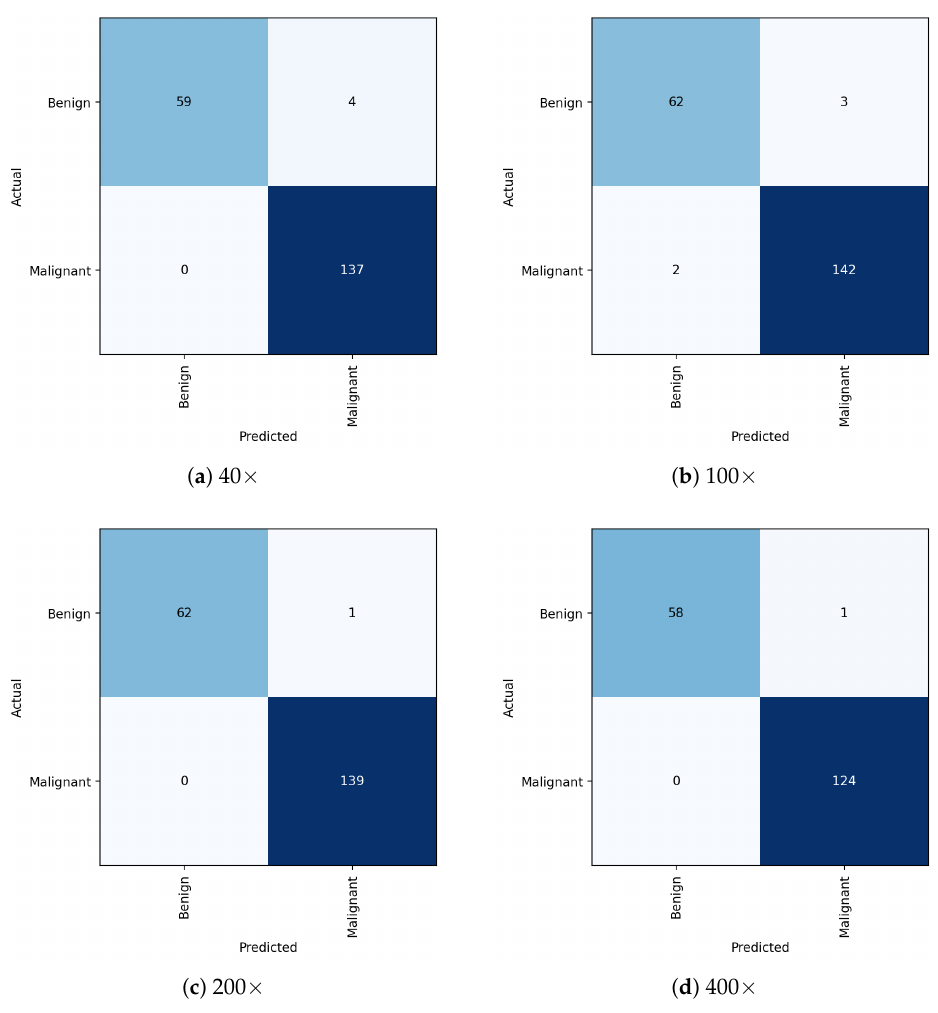
Figure 4. Illustration of the binary class confusion matrix obtained through the proposed model on the test set. Note that ( a – d ) refer to the 40 × , 100 × , 200 × , and 400 × magnifications, respectively.